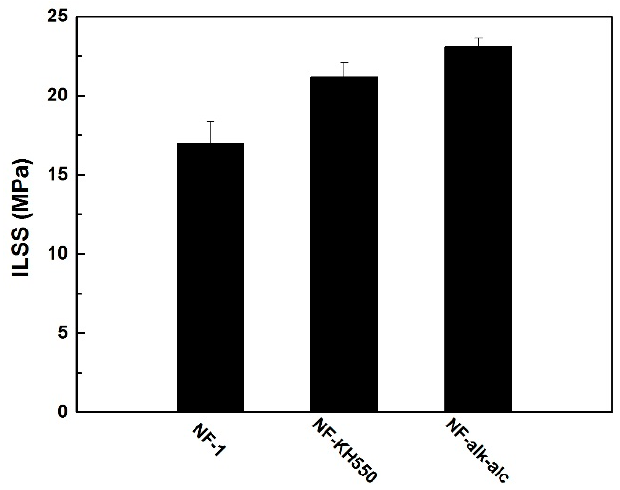
Figure 13. Interlaminar shear strength of different modified ramie fabrics reinforced APA-6 composites.